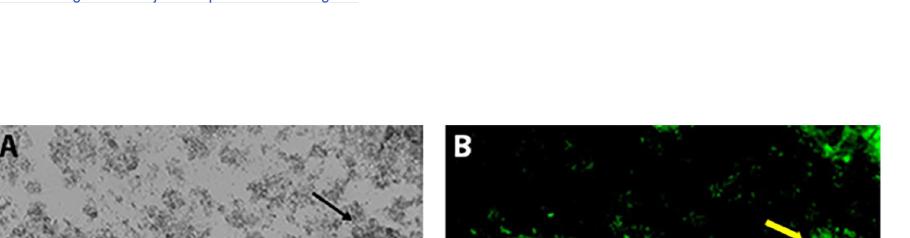
Fig 7. Representative images of green fluorescence within rat aortic smooth muscle cells exposed to pNPs containing quercetin. pNP suspensions at 2 mg/mL were allowed to bind to cells for two hours before washing with buffer. Some sets of cells were subjected to a calcification treatment prior to pNP exposure (right panel). Green fluorescence was imaged after washing. Yellow bar = 100 μ m. For better visibility, yellow bars were added as an overlay to automatically saved scale bars.